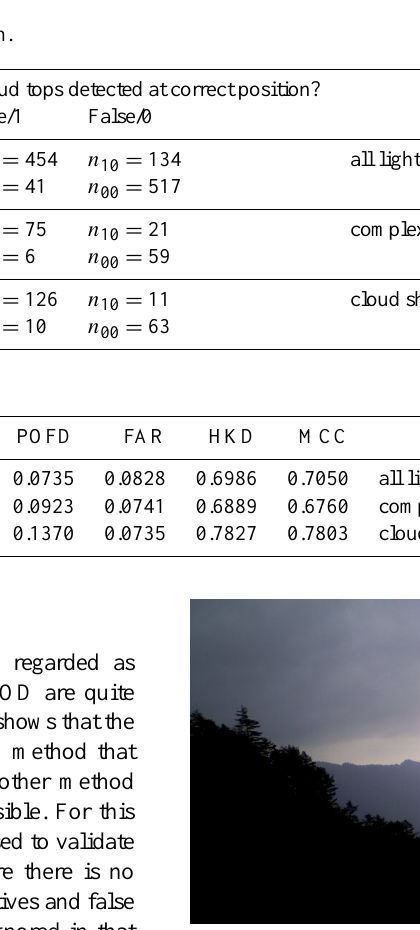
Figure 16. Cloud tops (green) detected in the scene taken on 15 March 2013 from 09:02 to 09:06UTC +